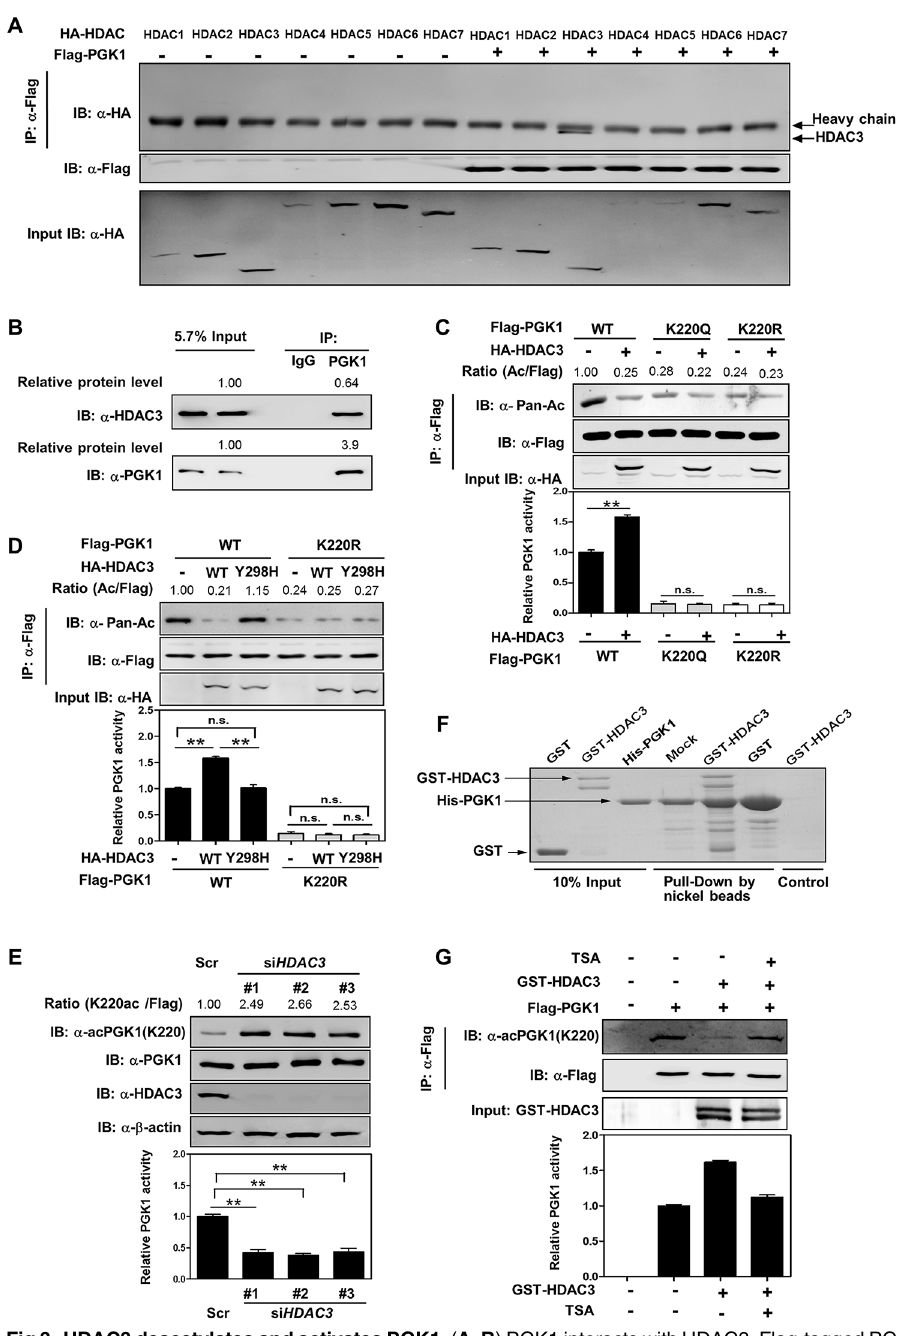
Fig 3. HDAC3 deacetylates and activates PGK1. ( A, B ) PGK1 interacts with HDAC3. Flag-tagged PGK1 was overexpressed in HEK293T cells together with the individual HA-tagged HDAC as indicated. PGK1 protein was purified by IP with Flag beads, following western blot to detect HDACs with a human influenza hemagglutinin (HA) antibody (A). In addition, PGK1 protein was purified by IP with PGK1 antibody, following western blot to detect its interacting endogenous HDAC3 (B). ‘ 5.7% input ’ refers to 5.7% of total proteins for IP experiments were loaded. Based on the protein amount as determined by western blotting and chemiluminescent detection, the protein level of immunorecipitated PGK1 is 3.9 times of PGK1 input, and the protein level of co-immunorecipitated HDAC3 is 0.64 times of HDAC3 input. Thus, the IP efficiency for PGK1 is 3.9 × 5.7% = 22.2%, and the co-IP efficiency for HDAC3 is 0.64 × 5.7% = 3.6%. This indicates that ~16% (3.6%/22.2% = 16%) of endogenous HDAC3 interacting with PGK1. ( C ) HDAC3 deacetylates PGK1 mainly at the site of K220. Flag-tagged wild-type and K220 mutant PGK1 were each expressed in HEK293T cells